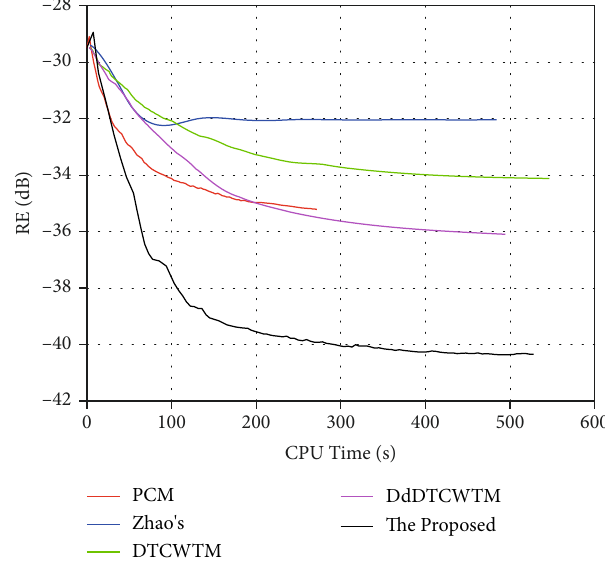
Figure 7: The RE curves for the second dataset.